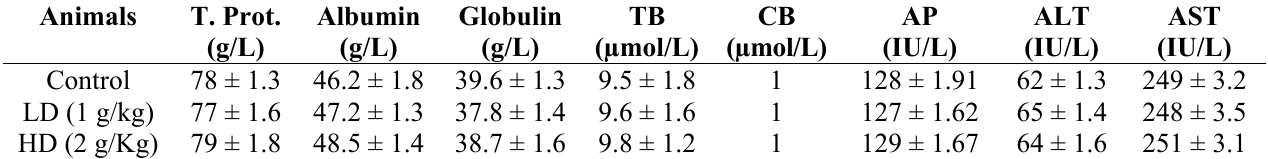
Values expressed as mean ± S.E.M. There are no significant differences between groups. Significant value at p < 0.05 T. Prot; total protein, TB: Total bilirubin; CB: Conjugated